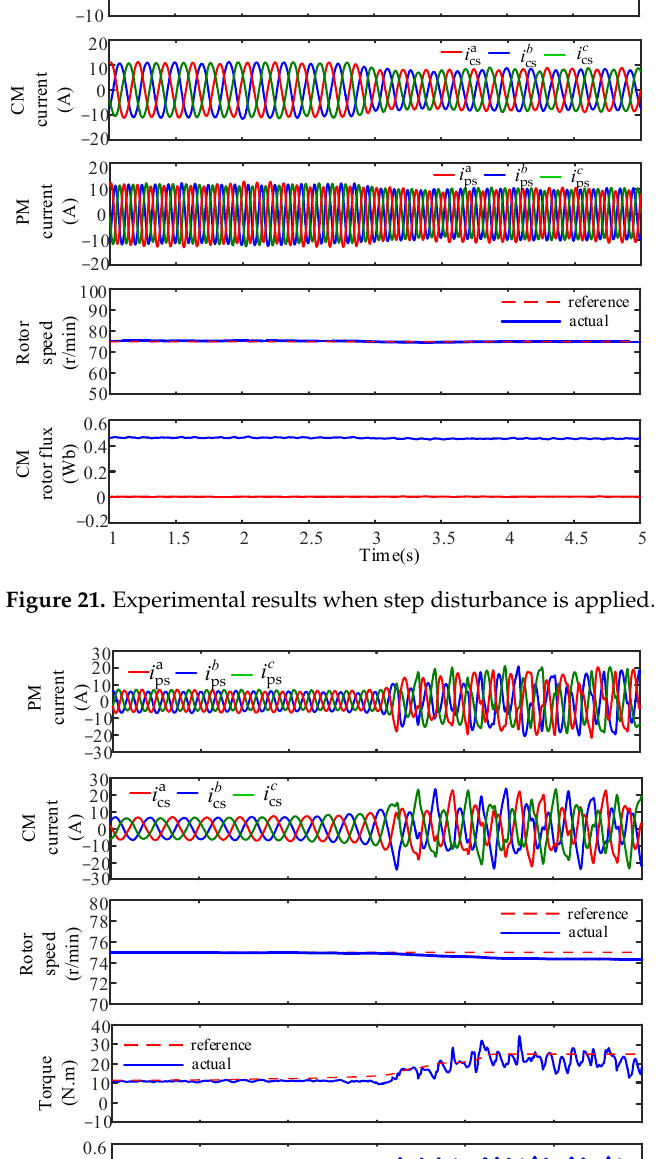
Figure 20. Experimental results with step change of speed.